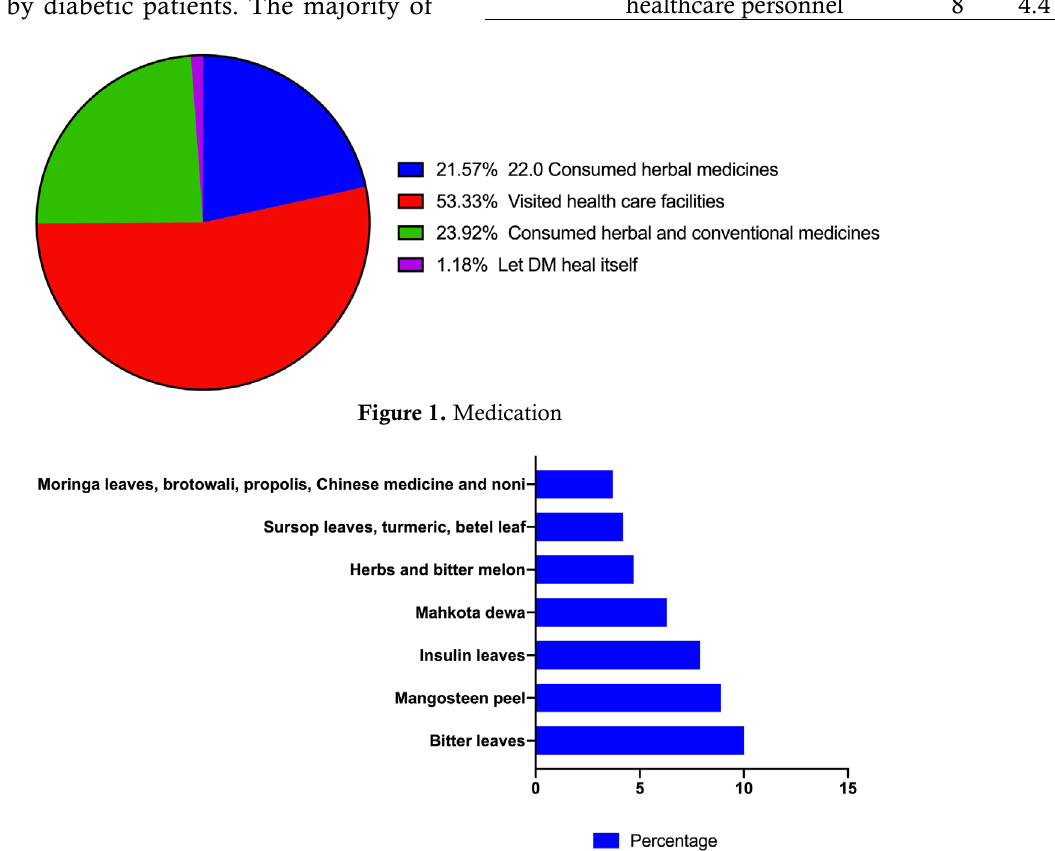
Figure 2. Percentage of the herbal medicine used in patients with